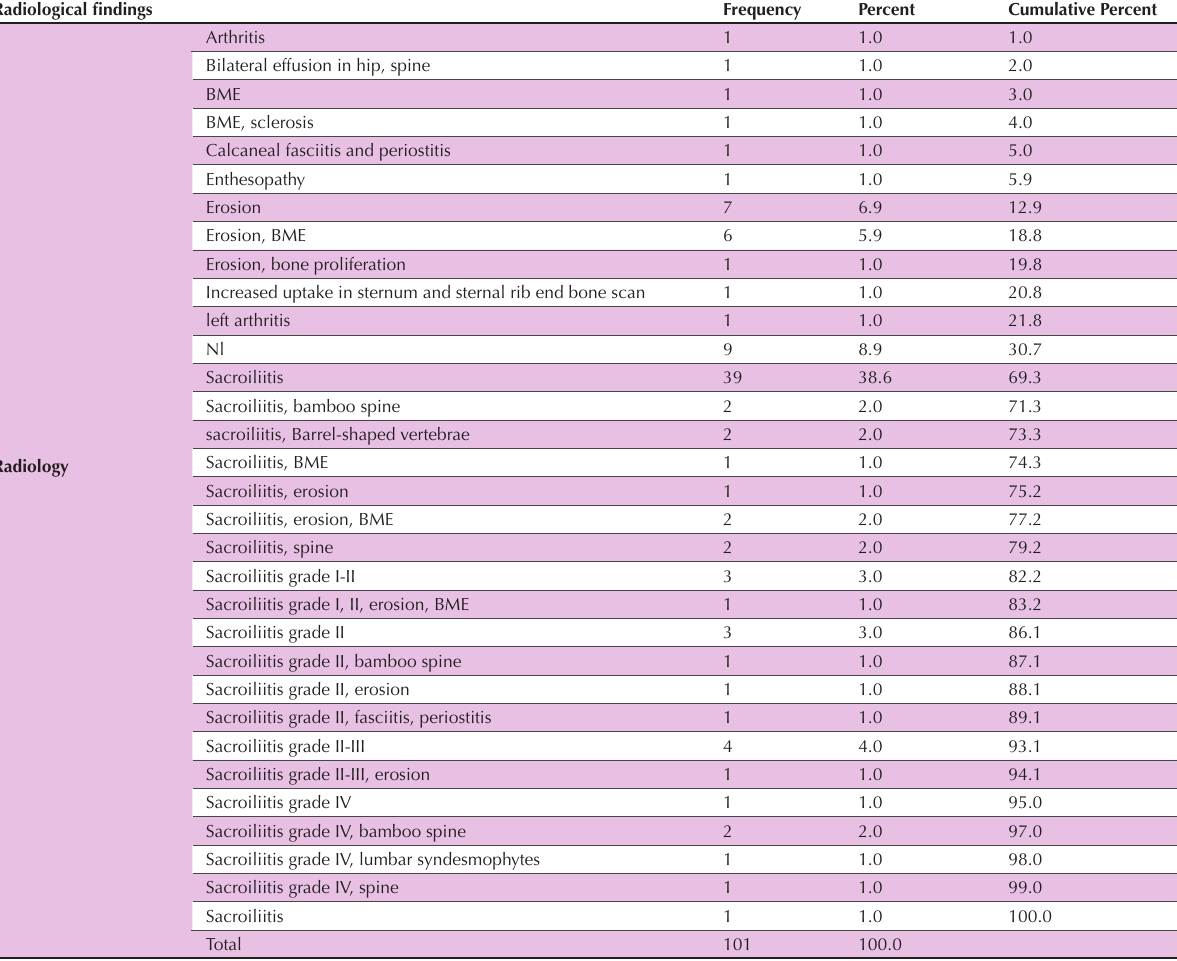
Table 4. Frequency of various radiological manifestations of the disease among patients Radiological